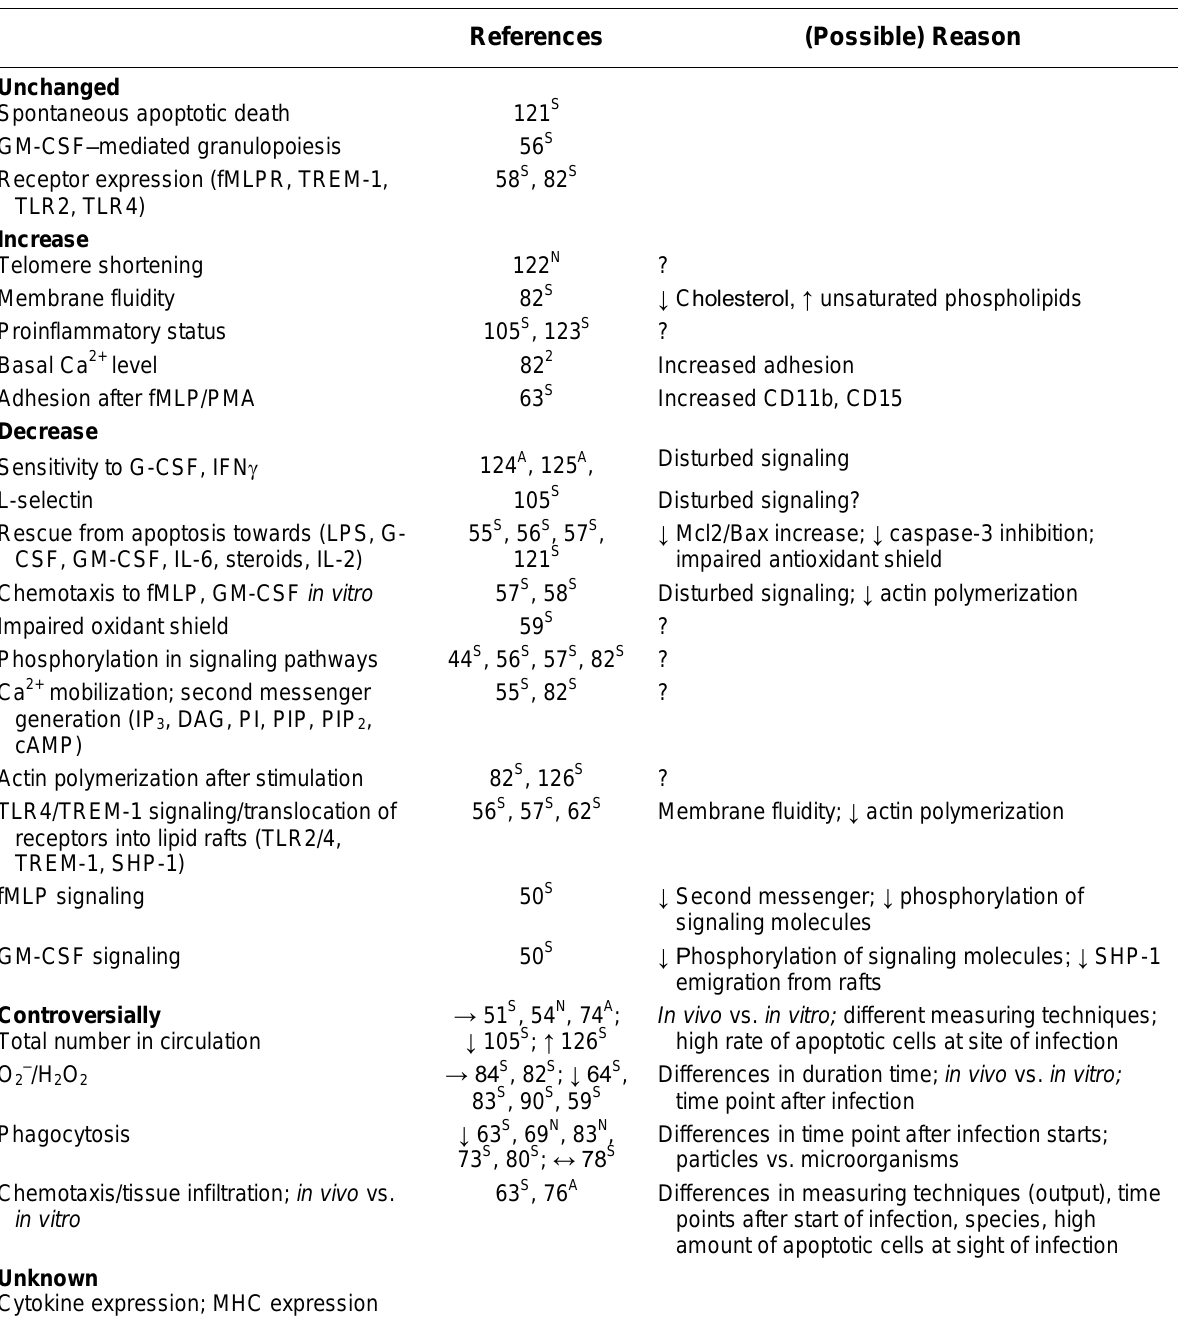
Age-Related Changes in Neutrophil